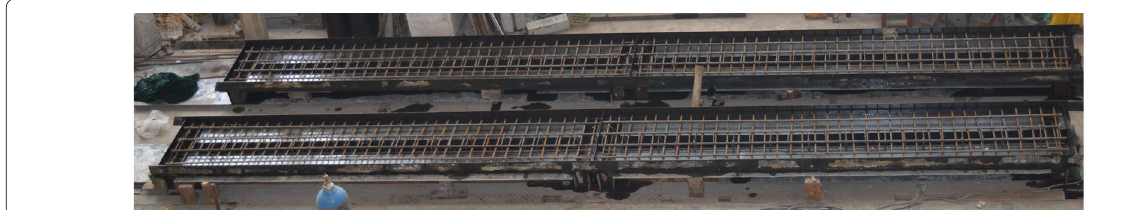
Fig. 3 Assembly of the form and arrangement of the rebar.